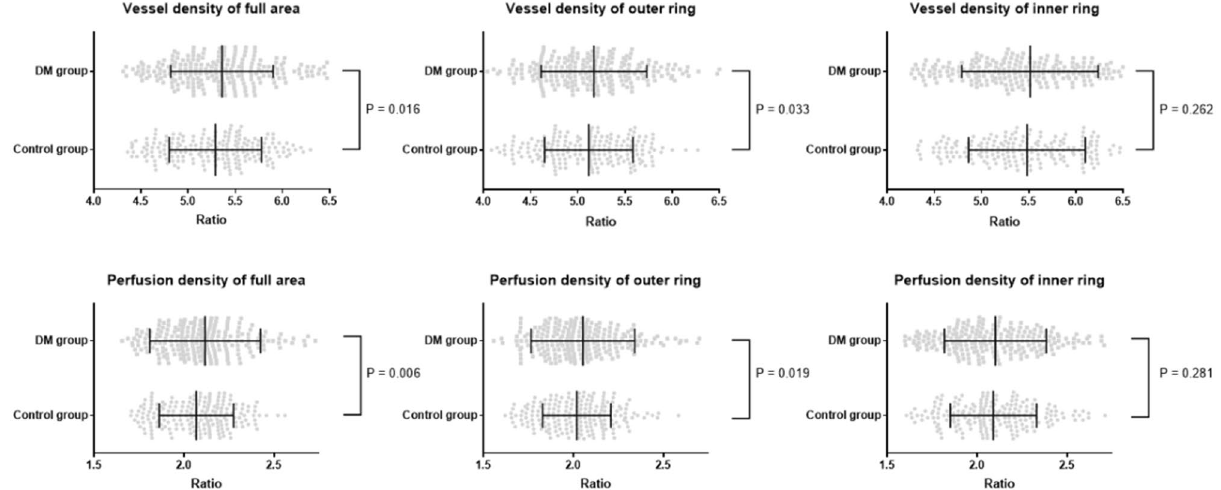
Figure 2. Scatter plots showing the mean RNFL thickness/parameters of optical coherence tomography angiography ratio in each